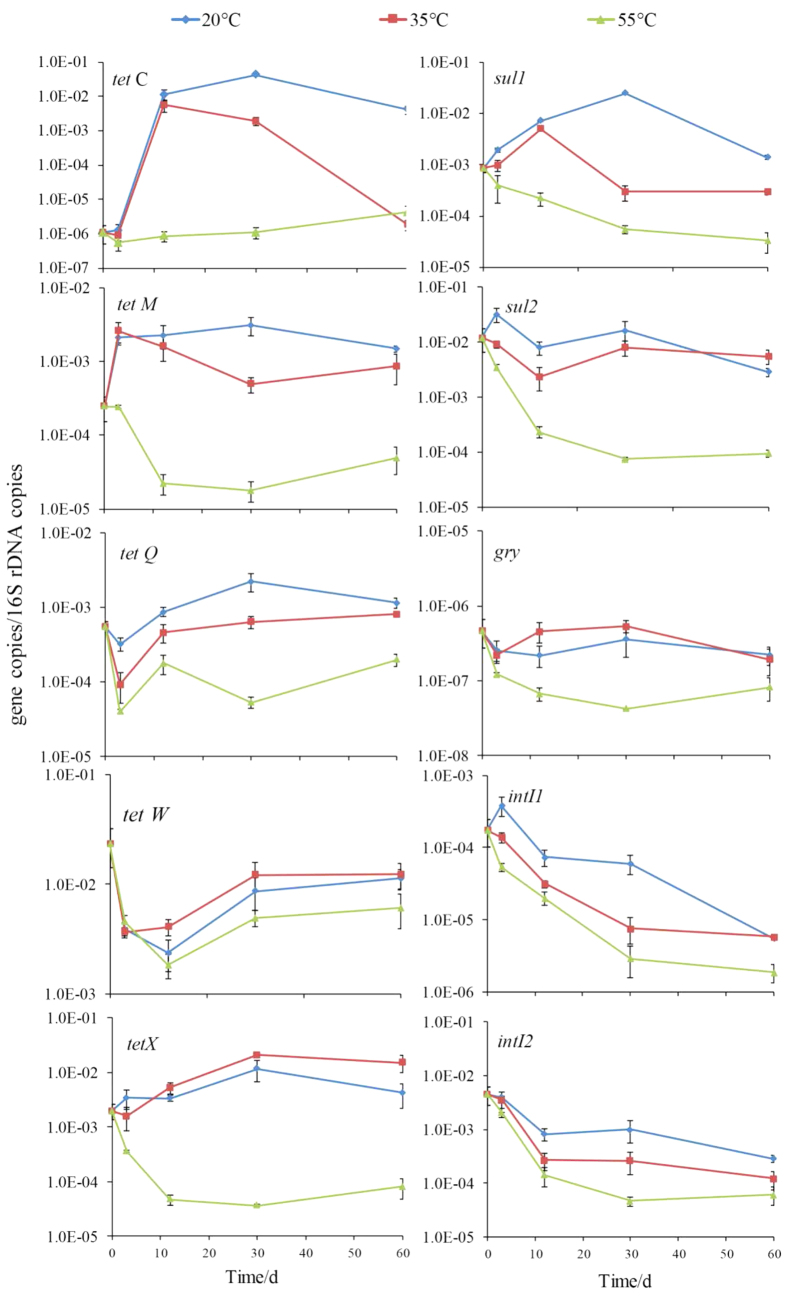
Variation in ARGs/16S rRNA gene and integrase genes/16S rRNA gene detected during anaerobic digestion at 20 °C, 35 °C, and 55 °C.Bars represent standard deviations (n = 3).